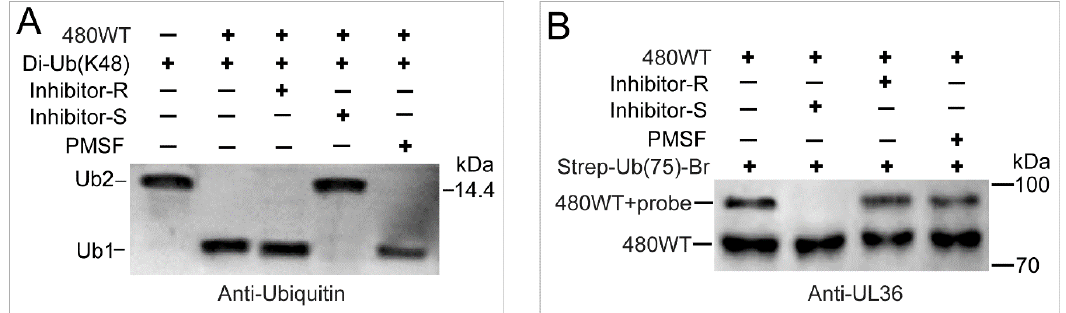
Figure 9. The interference of inhibitor on the activity and binding of UL36(480) wild type protein. ( A ) The inhibition of inhibitors on the deubiquitinating activity of UL36(480) wild type on di-Ub(K48)